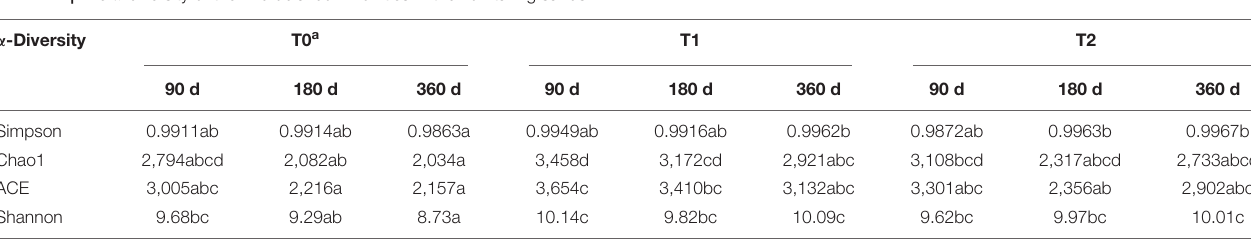
TABLE 2 | The α -diversity of the microbial communities in the iron tailing sands.